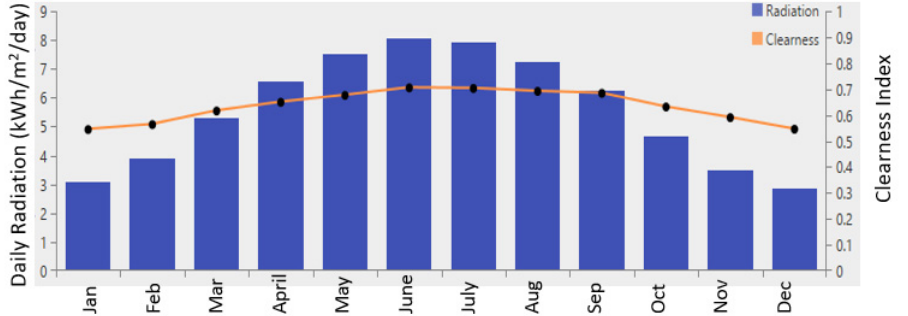
Figure 3. Monthly average for global horizontal radiation in kWh/m 2 /day, over a 22-year period (Jul. 1983–Jun. 2005), Homer Pro.